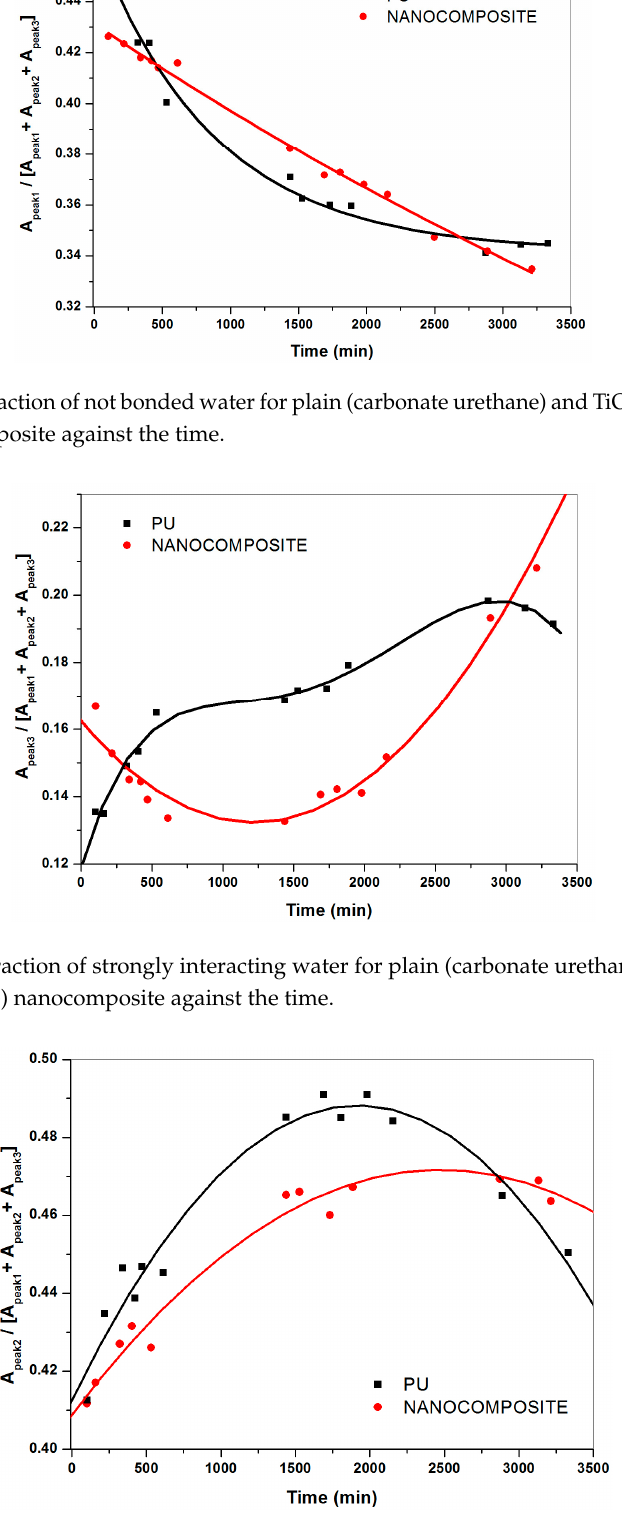
Figure 10. Relative fraction of weakly interacting water for plain (carbonate urethane) and TiO 2 /poly (carbonate urethane) nanocomposite against the time.